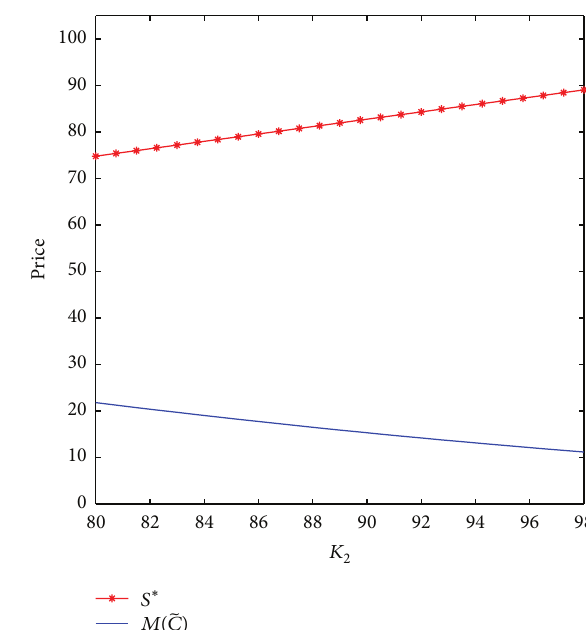
𝑀(̃𝐶) with respect to 𝐾 2 .